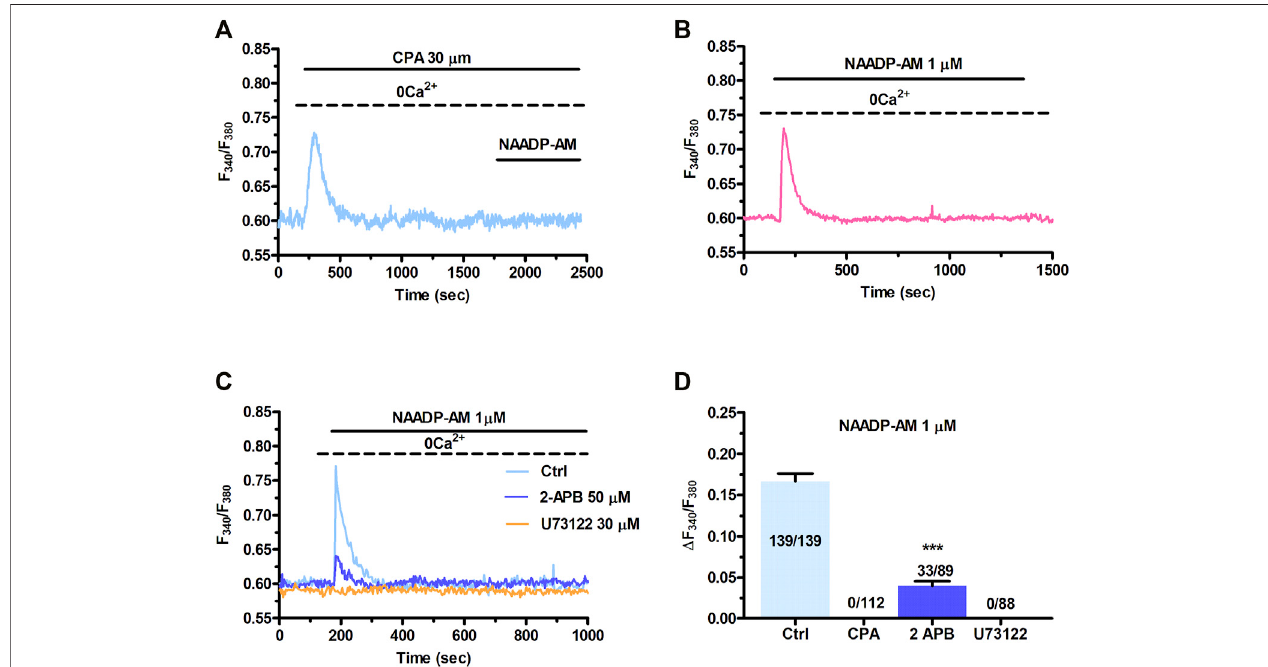
FIGURE 3 | InsP 3 Rs support the Ca 2+ response to NAADP. (A) Administration of NAADP-AM (1 µM) after the pharmacological depletion of the ER Ca 2+ pool with CPA (30 μ m, 30 min) failed to induce intracellular Ca 2+ release. CPA induced a transient increase in [Ca 2+ ] i that re fl ects passive ER Ca 2+ leakage from the ER. (B) The intracellular Ca 2+ transient evoked by NAADP-AM (1 µM) in the absence of extracellular Ca 2+ (0Ca 2+ ) under control conditions. (C) The intracellular Ca 2+ release evoked by NAADP-AM (1 µM) under control (Ctrl) conditions was severely affected by blocking InsP 3 Rs with 2-APB (50 μ m, 30 min) or inhibiting PLC activity with U73122 (10 μ m, 10 min). (D) Mean ± SE ofthe amplitude ofthe peak intracellular Ca 2+ response to NAADP-AM under the designated treatments. Student ’ st-test: *** p <